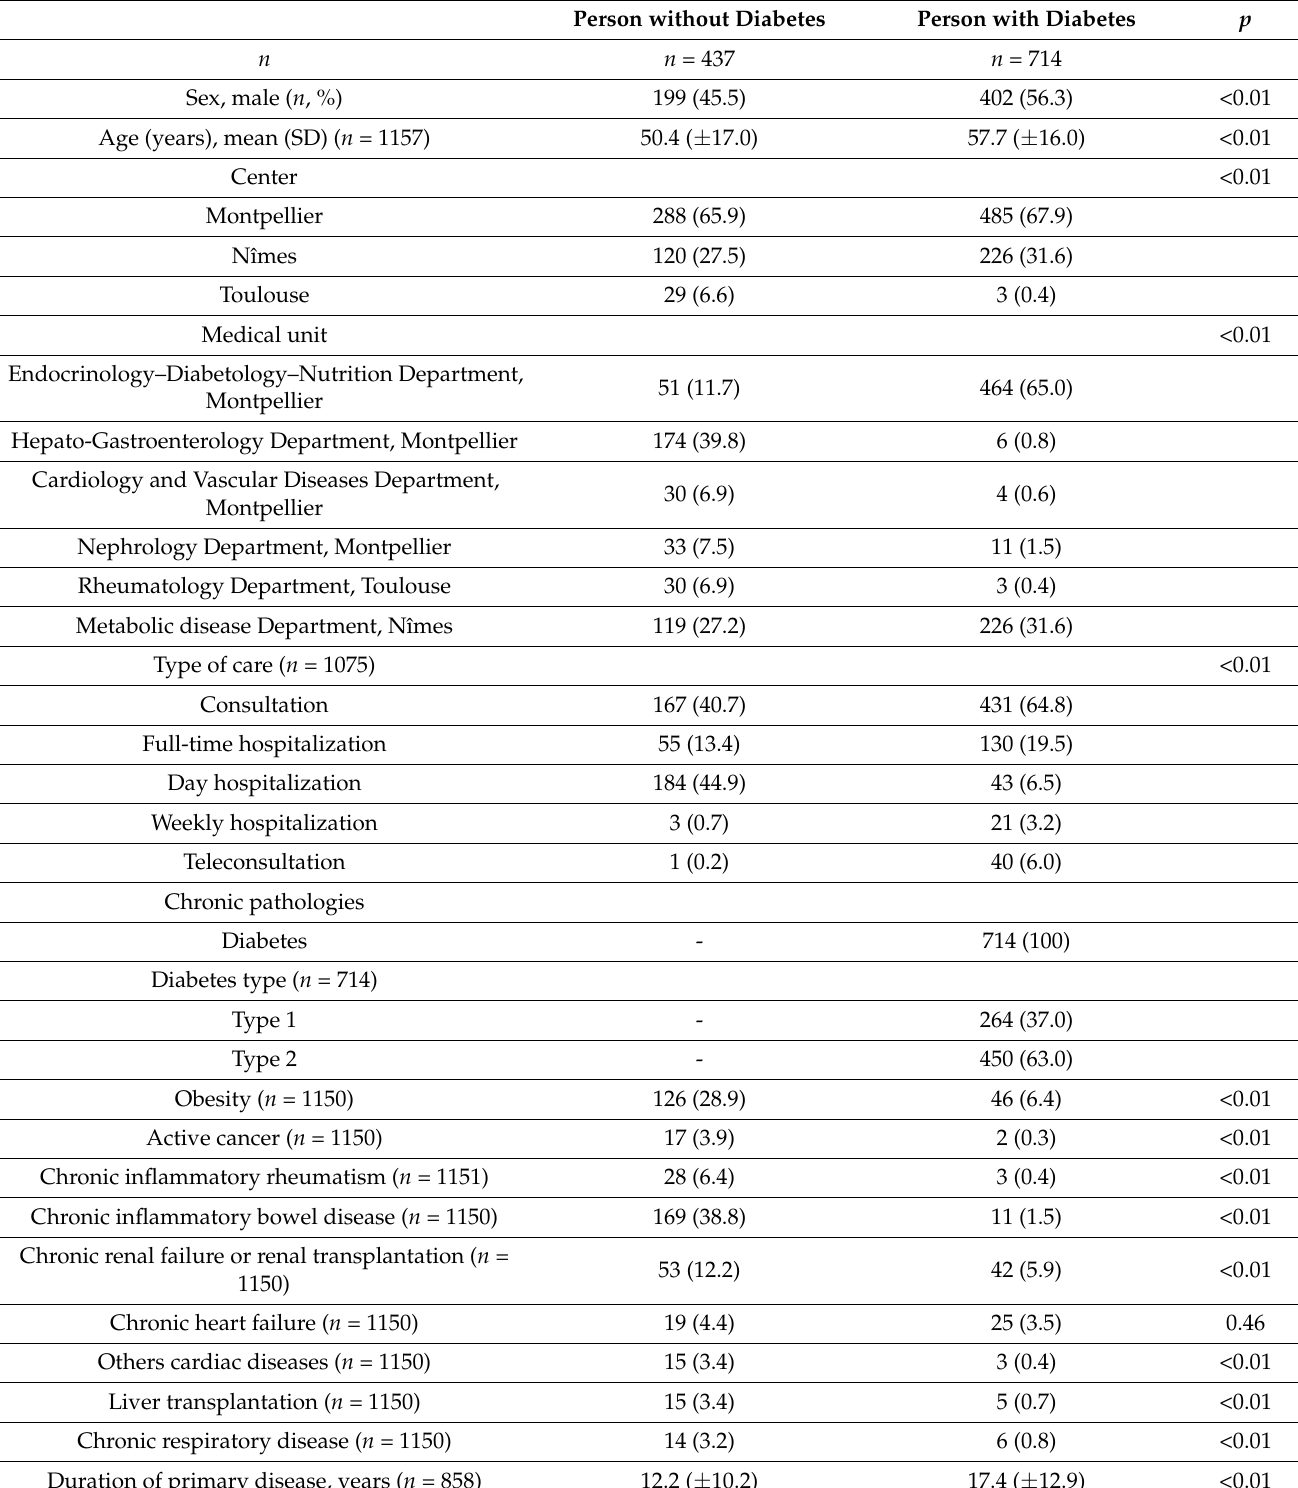
Table 1. Characteristics of the population. Person without Diabetes Person with